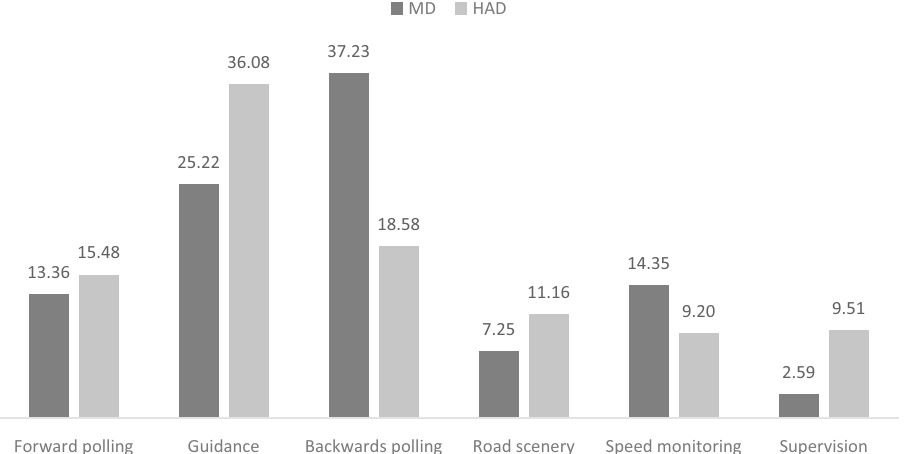
Figure 6. Percentage of scan paths of length 3 in the different visual sequence classes under Manual Driving (MD) and Highly Automated Driving